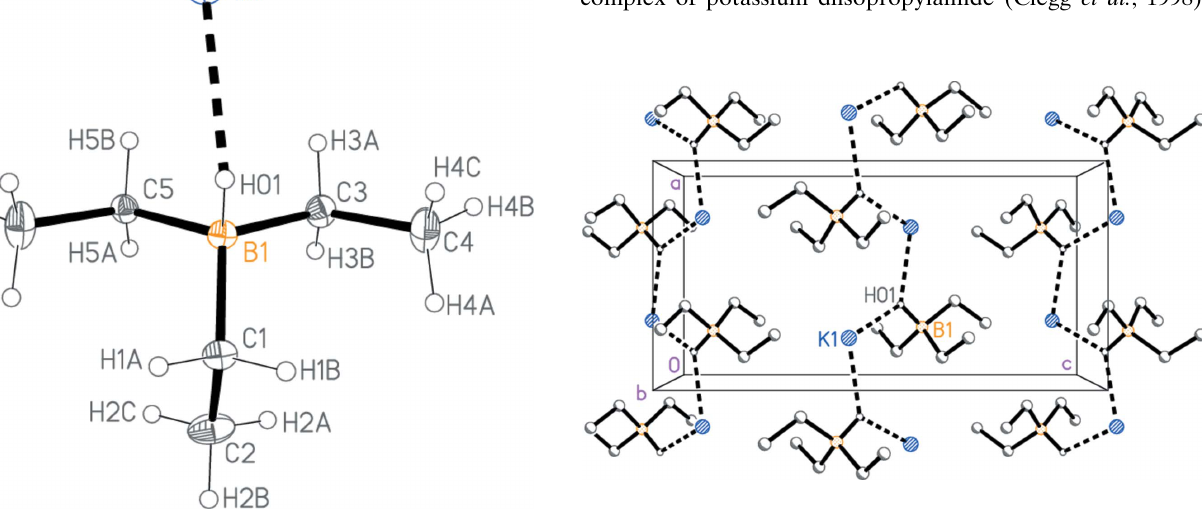
Figure 1 The asymmetric unit of KHBEt 3 . Ellipsoids are drawn at the 50% level. Only the shortest K1—H contact is drawn explicitly.